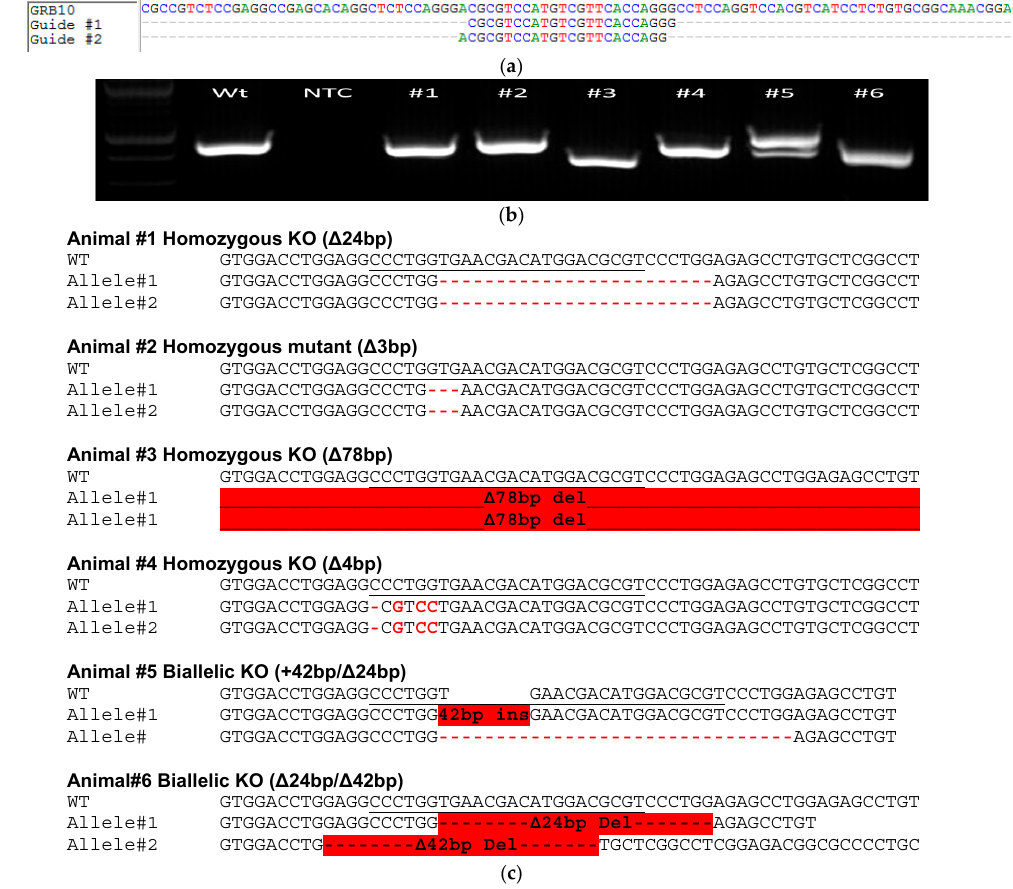
Figure 2. Genotyping of GRB10 in day 60 cloned Ossabaw fetuses. ( a ) Multiple sequence alignment showing the two guide sequences relative the wild type sequence in Exon 4 of GRB10 gene; ( b ) Agarose gel electrophoresis image of GRB10 amplicons from fetuses (numbered 1–6) showing noticeable shift in size in Fetus #3 and #6 and two differently targeted alleles in Fetus #5. Amplicon from wildtype (WT) animal is shown as a reference; ( c ) Genomic DNA was extracted from ear and tail biopsies, cloned into PCR2.1 vector, and 10 representative bacterial clones from each sample and from each fetus was sequenced by Sanger sequencing, confirming biallelic edits in all six fetuses. Table 1. Developmental competence of reconstructed cloned embryos followed by single guide RNA (sgRNA) microinjection.